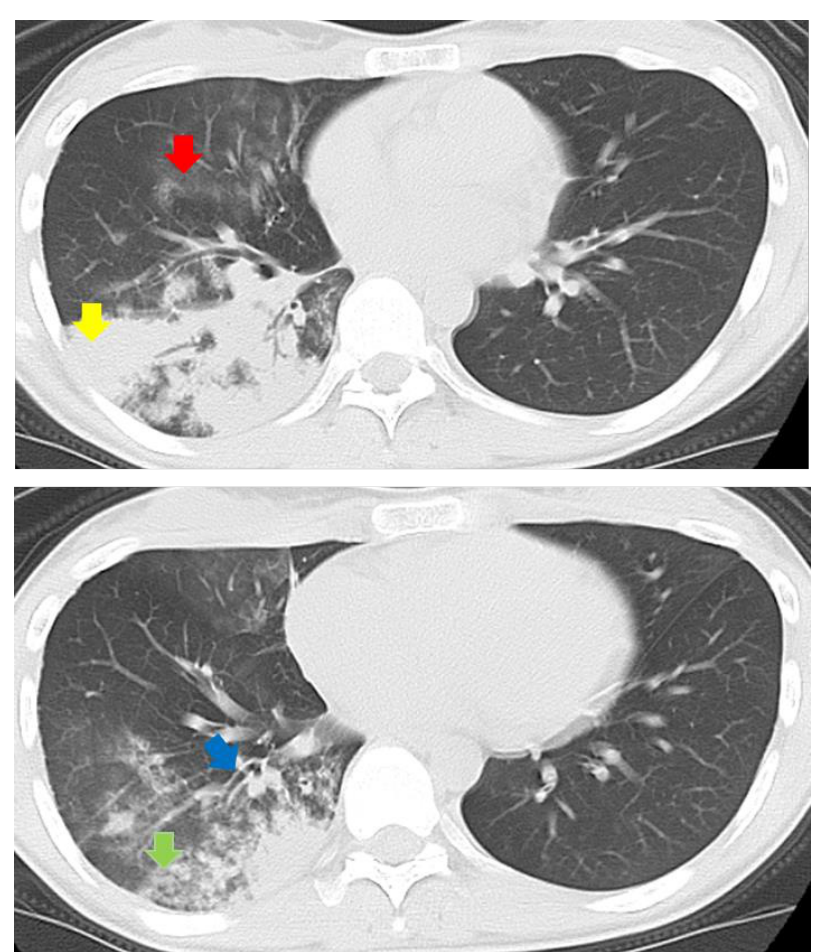
Figure 2. Chest CT of a 24-year-old Japanese woman with MPP showed various findings such as ground-glass attenuation (red arrow), consolidation (yellow arrow), centrilobular nodules (green arrow), and branchial wall thickening (blue arrow).